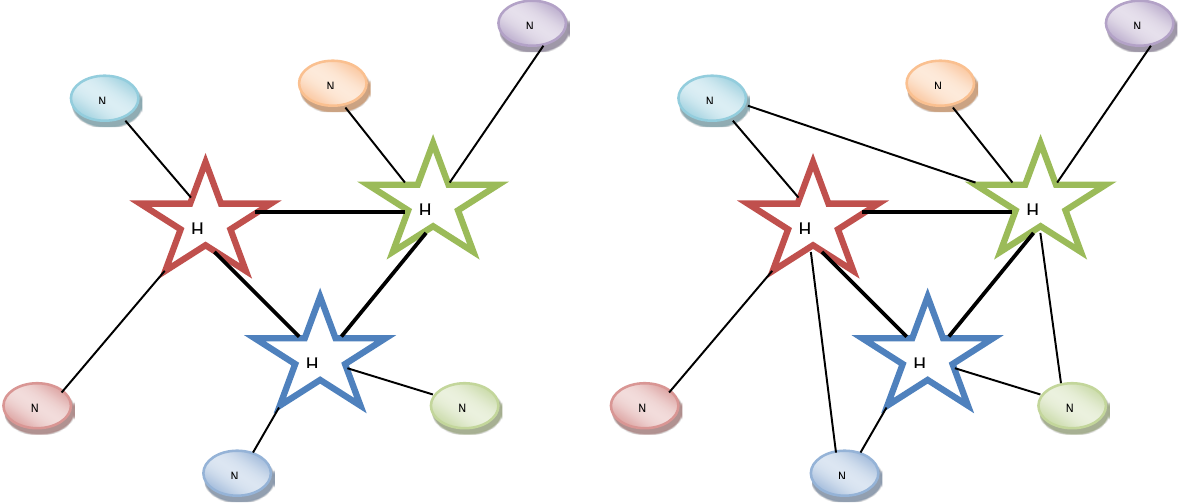
Fig. 1. A single allocation (left hand side) and multiple allocation (right hand side) hub